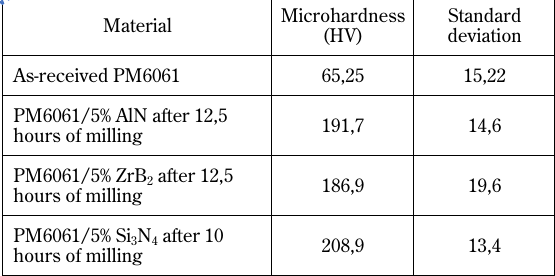
Table 3 Microhardness of the as-received aluminium powder and the mechanically alloyed composite powders. Material